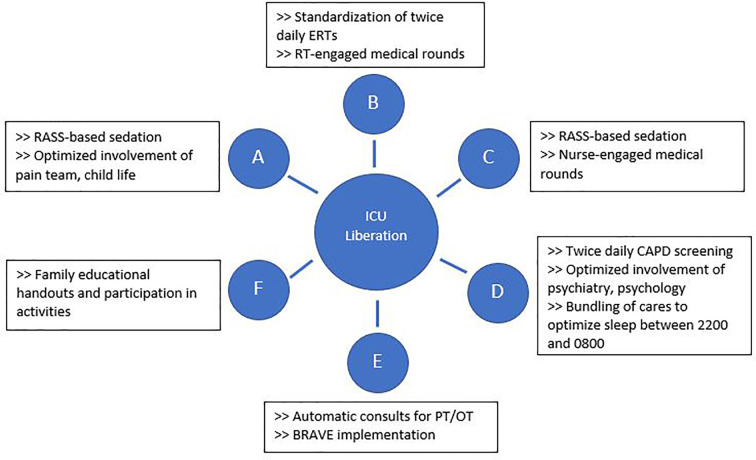
Interventions implemented through Plan-Do-Study-Act cycles to address each aspect of the ABCDEF intensive care unit liberation bundle. BRAVE, Beginning Restorative Activities Very Early; CAPD, Cornell Assessment of Pediatric Delirium; ERTs, extubation readiness trials; OT, occupational therapy; PT, physical therapy; RT, respiratory therapists.